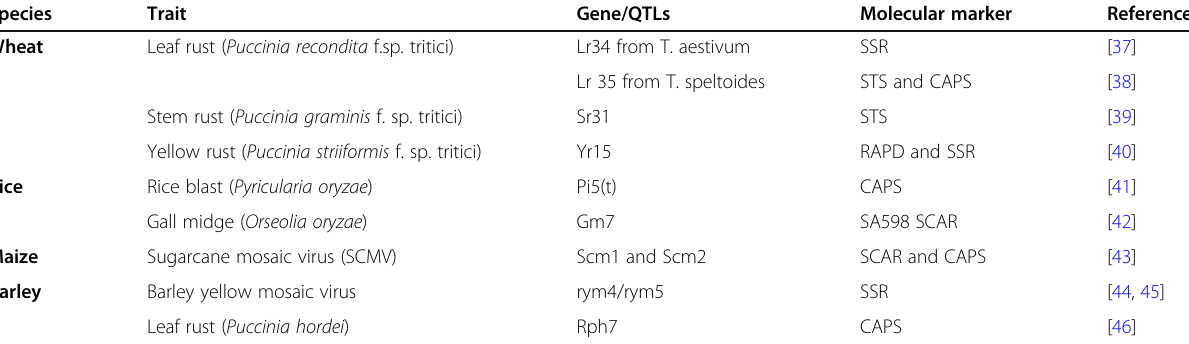
Table 2 The gene – marker association for disease resistance in different crops